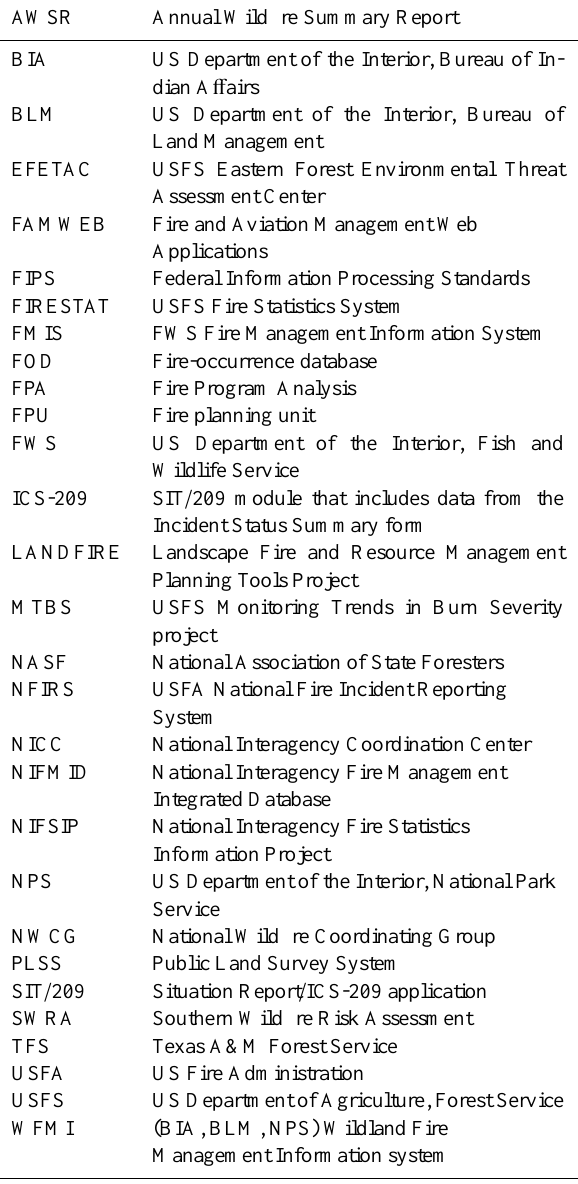
Table A1. Key abbreviations, acronyms, and aliases and their defi-